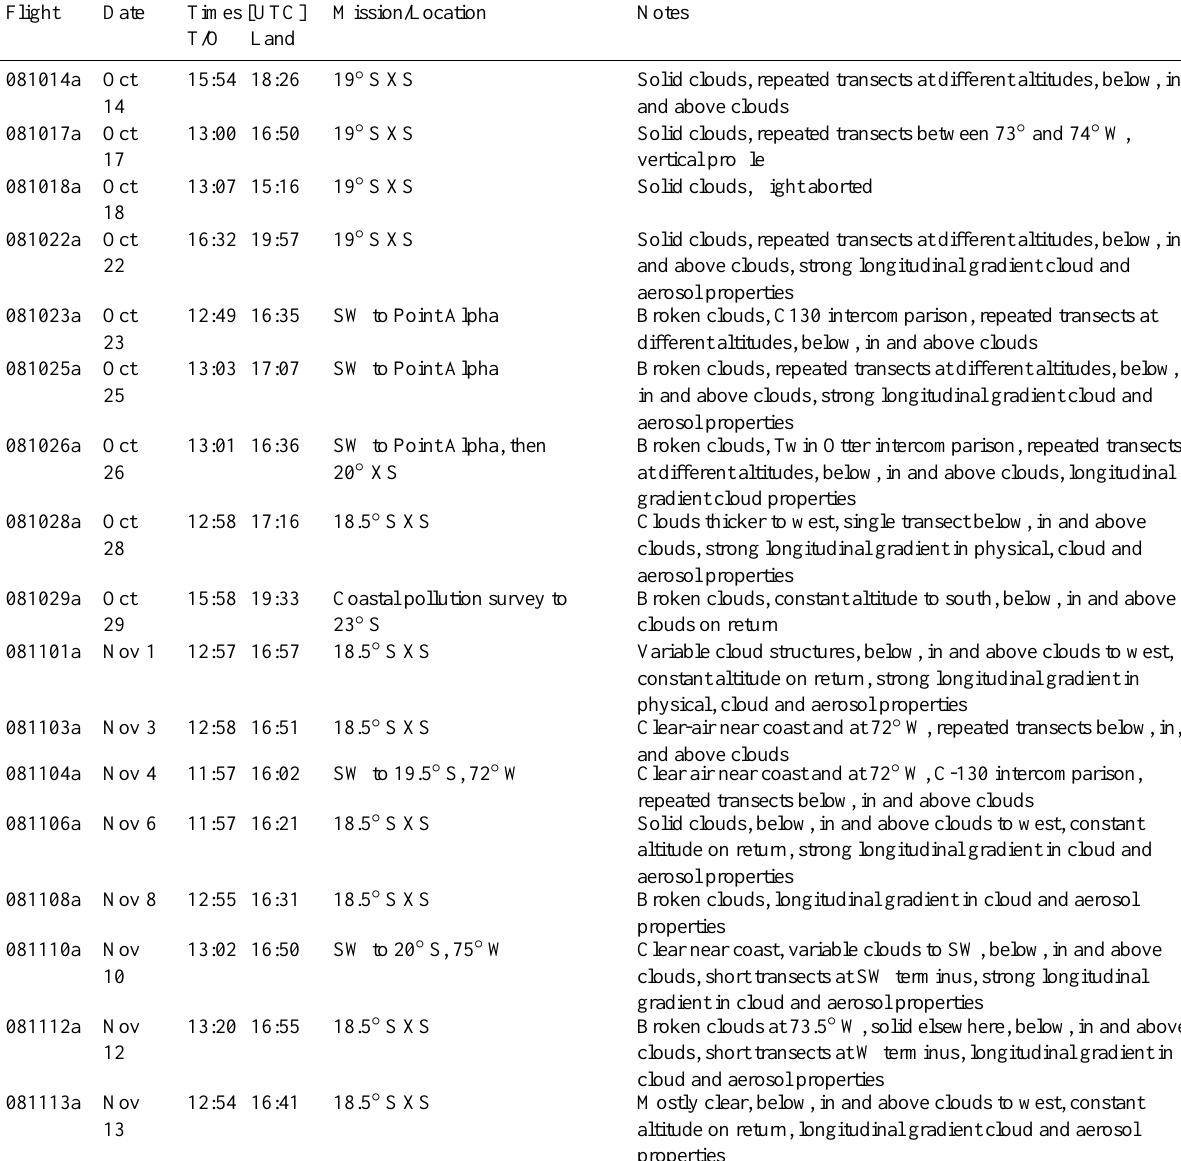
Table 8. Details of G-1 aircraft missions conducted in the VOCALS Regional